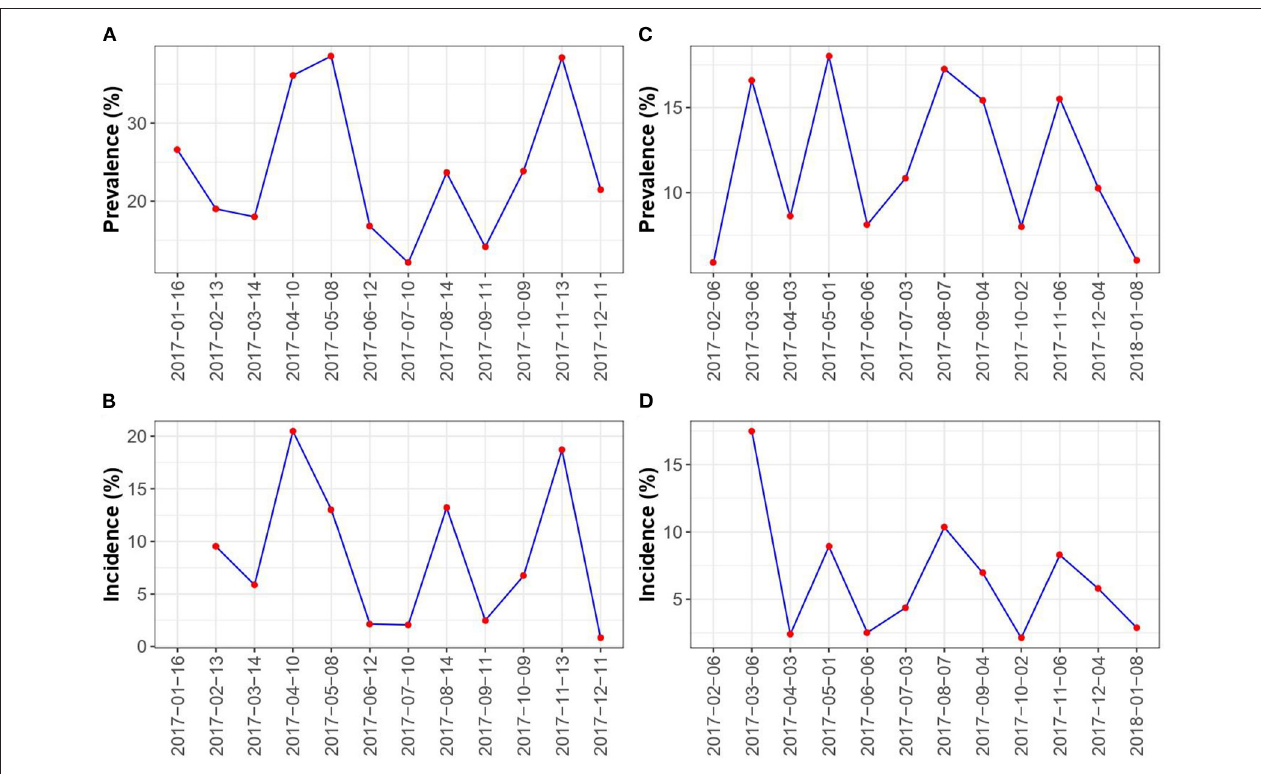
FIGURE 1 | Prevalence and incidence. This figure shows the estimated prevalence and incidence of Corynebacterium spp. infections over time in the two dairy cattle herds in this study [ (A,B) Herd 1, (C,D) Herd 2].